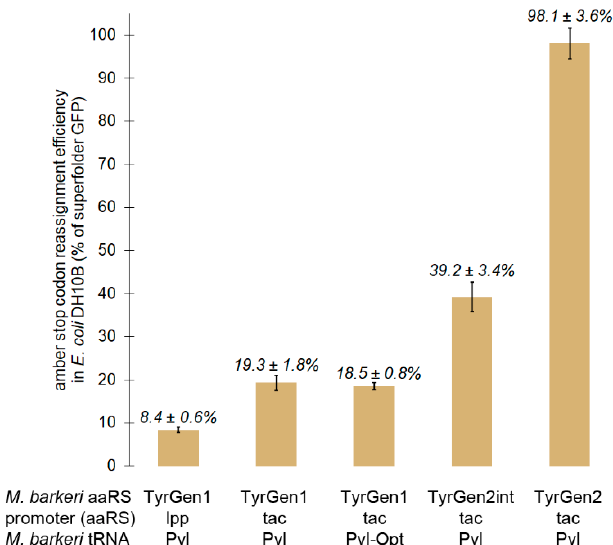
Figure 1. Progression of the efficiency of amber stop codon reassignment by evolved tyrosine- incorporating M. barkeri Pyl aaRS variants measured in E. coli DH10B. Efficiencies are presented as a percentage of the fluorescence of cells producing GFP with a Tyr codon specifying position 66.